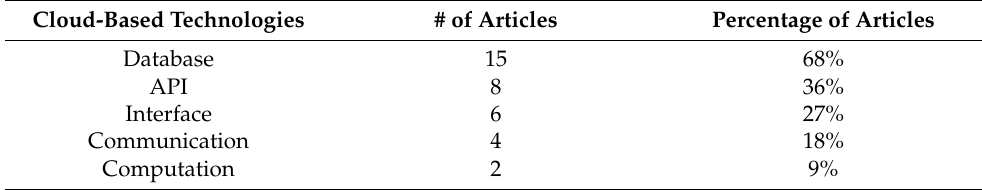
Table 7. Number and percentage of papers using certain cloud-based technology.